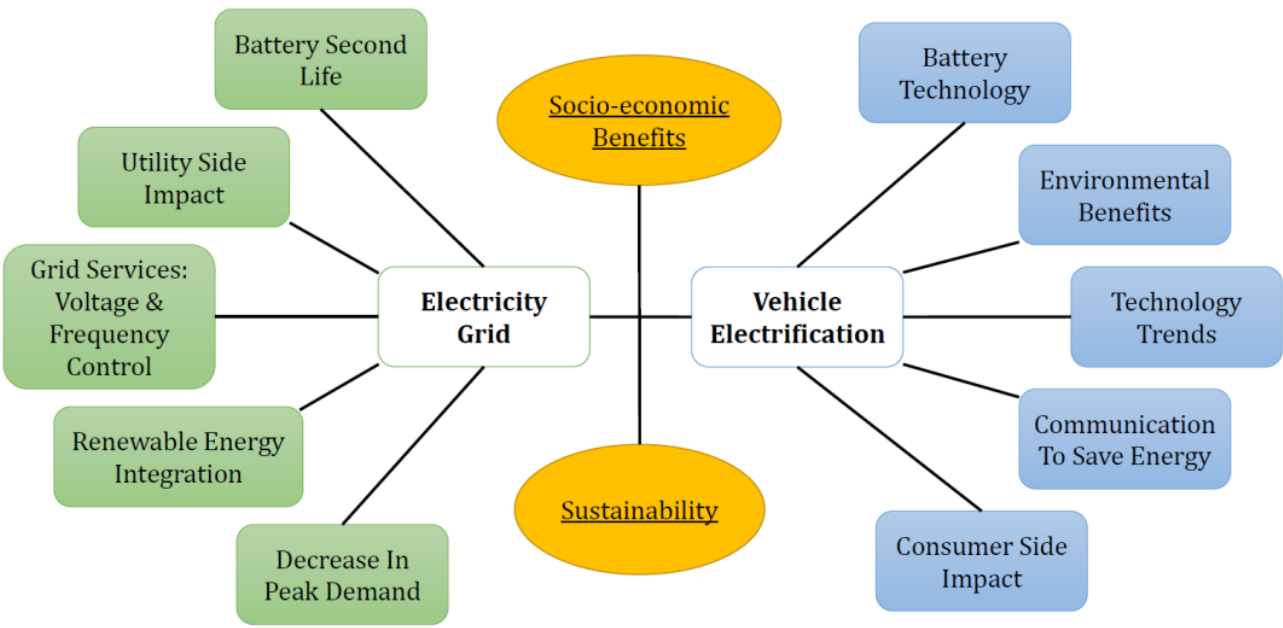
Figure 1. Services/Impacts/Concerns of Vehicle Integration in the Electricity Grid.